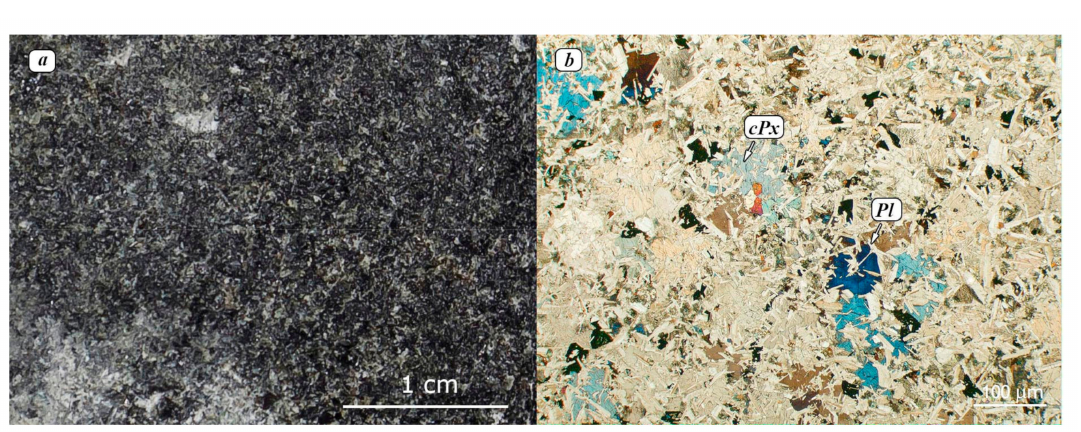
Figure 14. Photo ( a ) and photomicrorgaph ( b ) of gabbro-dolerite DL-1 ( Pl —plagioclase, cPx —clynopyroxene). The U–Pb system of Dl-1 zircons is highly homogeneous: the uranium and thorium content is moderately high: 1700–3700 and 1100–4700 ppm, respectively, the radiogenic 206 Pb content is 40–130 ppm, and a Th / U ratio (0.9–1.7) is typically magmatic. A concordant cluster of 8 U–Pb analyses corresponds to the age of 249.07 ± 0.92 Ma with an MSWD value of 0.2 and a probability of concordance at 0.7 (Figure 16). The weighted average age calculated on the 206 Pb / 238 U ratio for two analyzed baddeleyite grains corresponds to 250.8 ± 6.9 Ma. Within error limits, it coincides with the age obtained from zircons, but baddeleyite is characterized by an almost complete absence of thorium and moderate uranium of 100–120 ppm, whereas radiogenic 206 Pb does not exceed 3–4 ppm, which does not allow measuring the U / Pb ratio with an accuracy comparable to zircon (1 σ >